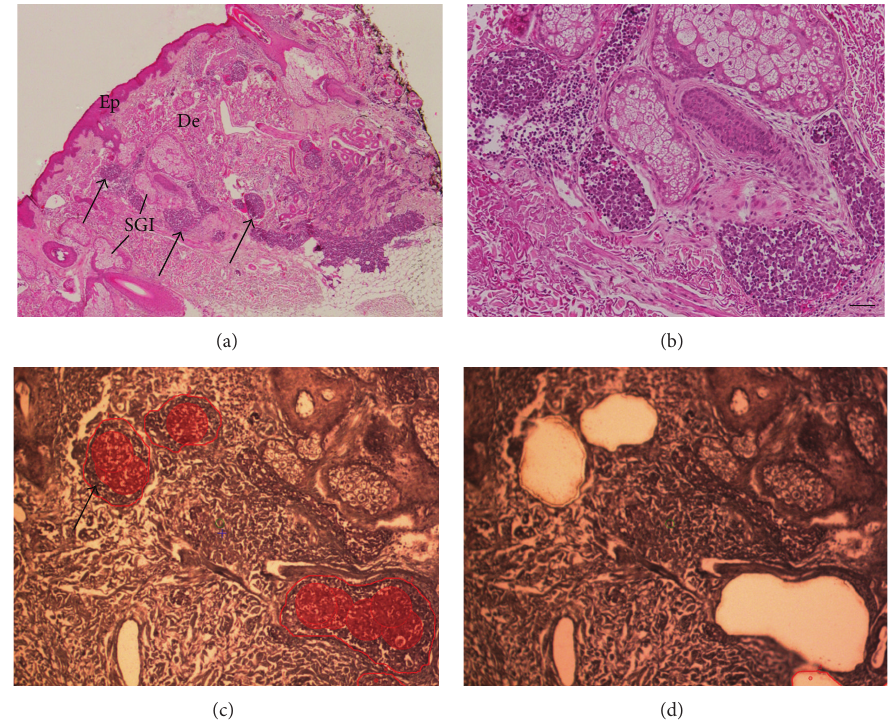
Figure 1: Representative example of histology of Merkel cell carcinoma from a tumor with poor prognosis. (a) Low power hematoxylin and eosin (H&E) stained photomicrograph. Arrows indicate regions of MCC to be microdissected. Dermis (De), epidermis (Ep), and sebaceous gland (SGI) are also indicated. (b) High power H&E image of same MCC. (c) Arcturus glass membrane hematoxylin counterstained serial section from same MCC. Areas to be laser capture microdissected are indicated by the arrow and red shading. The red punctate shading marks subsequent laser positioning. Using the Arcturus XT Microdissection System (molecular devices), these regions were transferred onto CapSure HS LCM Caps (Molecular Devices). Four caps were used per patient sample from the dissection of 1–4 sections representing approximately 5,000 tumor cells (1-2mm 2 area) captured per cap. (d) Image of the same membrane cut section after LCM. Magnification: (a) at 2X; (b), (c), and (d) at 10X. Scale bar = 50 𝜇